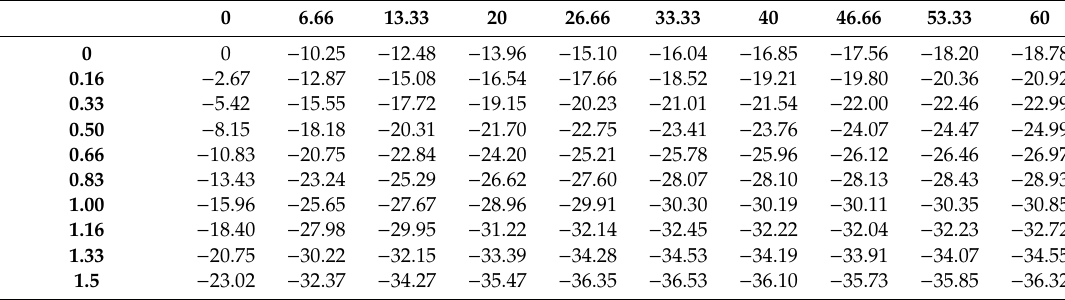
Table 3. Relative di ff erence values (%) describing the AOT-PWV combined e ff ect on shortwave irradiance for each combination of AOT and PWV